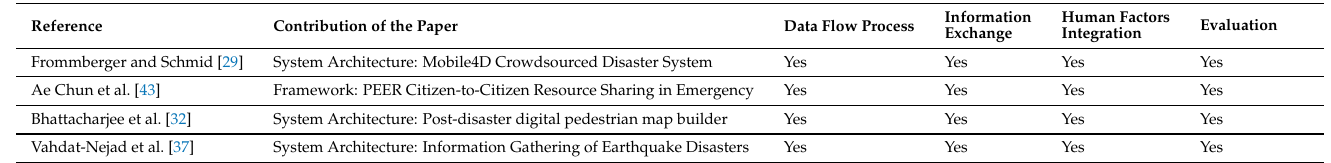
Table 4. Studies proposing process-based